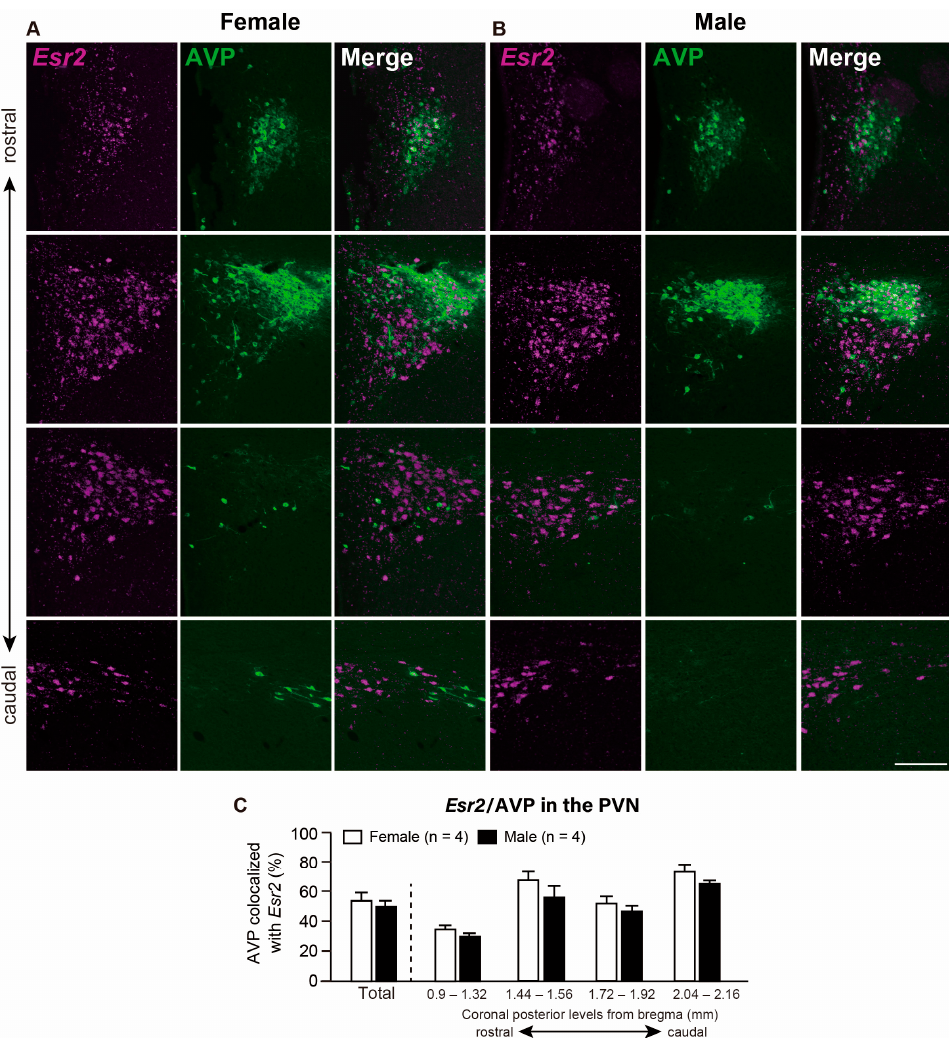
Figure 3. Co-expression of Esr2 and arginine vasopressin (AVP) in the paraventricular nucleus of the hypothalamus (PVN). Representative photomicrographs show dual labeling of Esr2 mRNA (magenta) and AVP (green) in the PVN of female ( A ) and male ( B ) rats. Scale bars indicate 200 µ m in A and B. ( C ) The percentage of AVP-ir cells co-expressed with Esr2 mRNA in the whole PVN and the PVN at different rostro-caudal levels (from bregma − 0.9 to − 2.16 mm). Values represent the mean ± SEM.